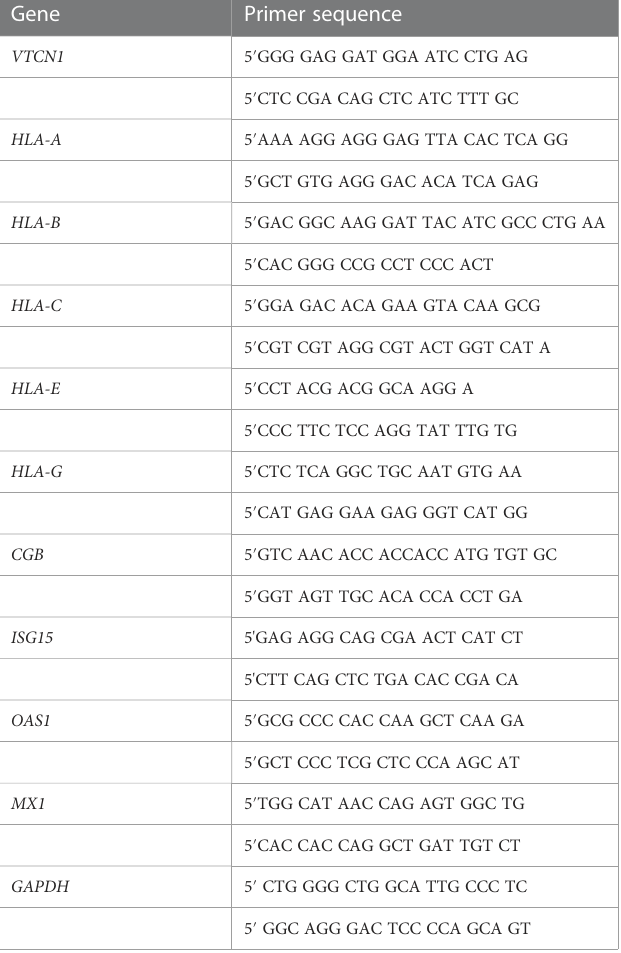
TABLE 1 Primers used for